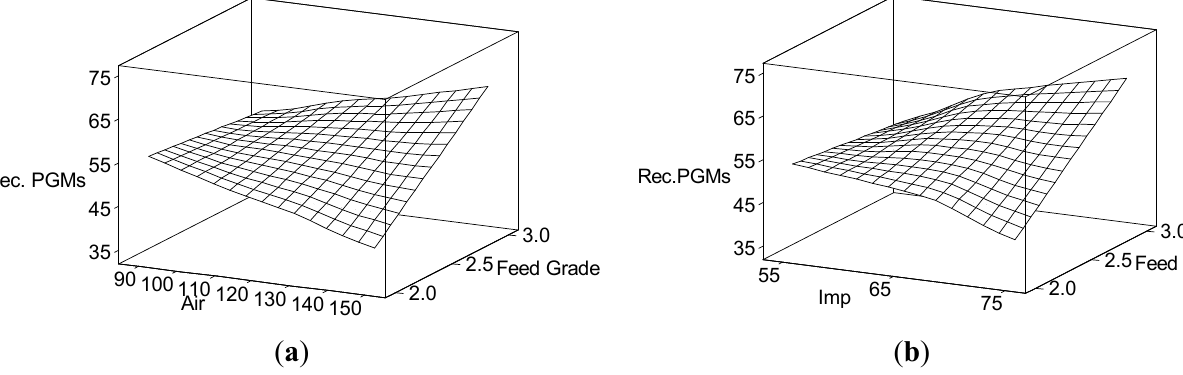
Figure 3. Response surfaces showing the dependency of PGM recovery on feed grade, air rate and impeller speed in a flotation pilot plant CCRD (data from [7]). ( a ) PGM recovery versus air versus feed grade and ( b ) PGM recovery versus impeller speed versus feed